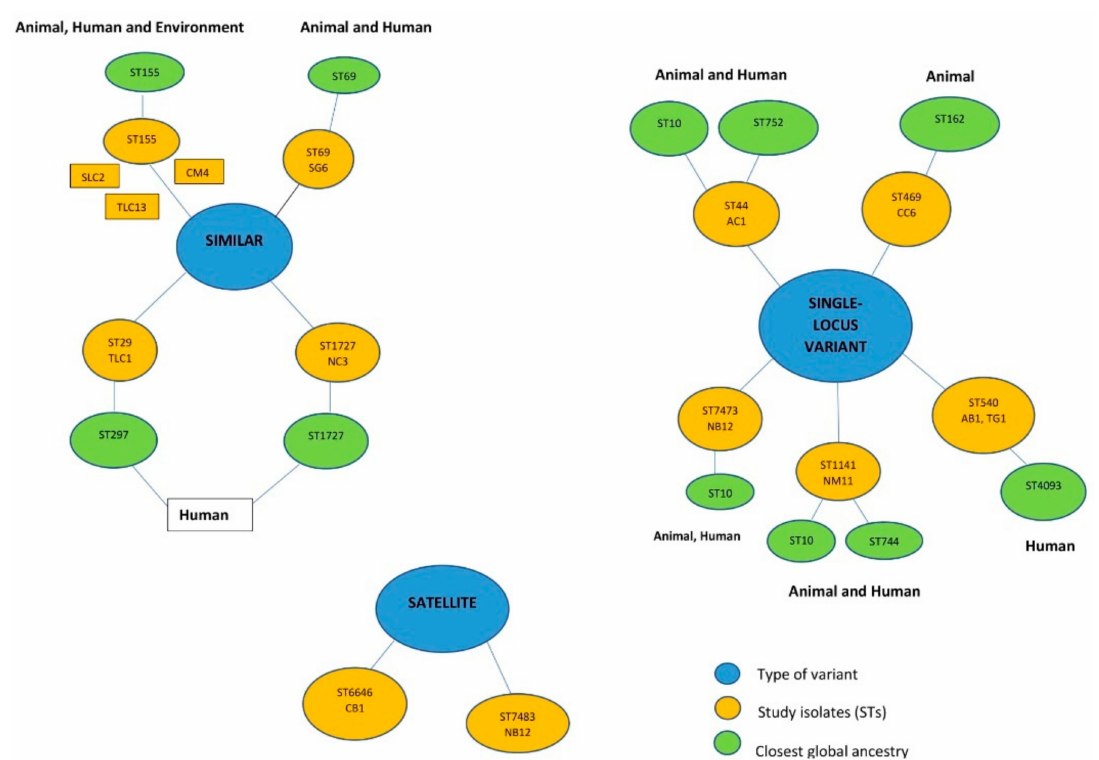
Figure 2. A graphical depiction showing the eBURST (Based Upon Related Sequence Types) analyses of the study sequence types with global curated STs in Escherichia PubMLST database using the Achtman scheme. eBURST identified four similar clones (have been reported), five single-locus variants (SLV), and two satellite lineages (more distantly) with global curated E. coli STs from animal (food), human, and environmental sources. The colour codes depicted the type of variant (blue), study isolates (STs) (orange), and closet global ancestry